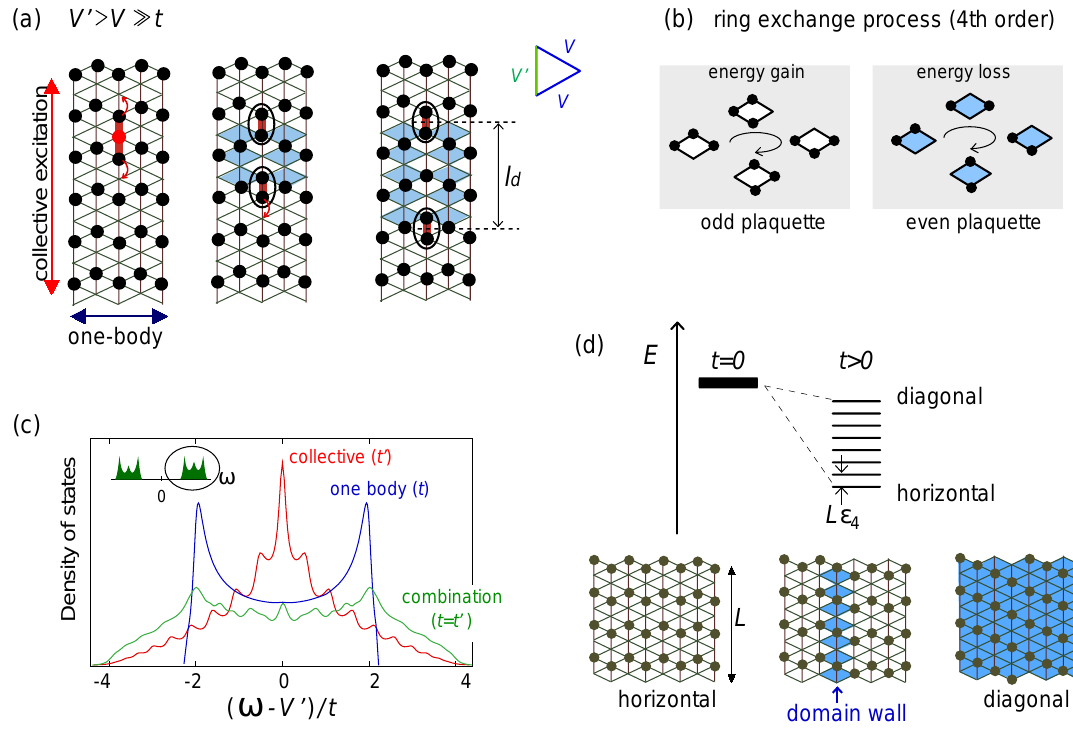
Figure 12. ( a ) Sketch of spinless particles in the strong coupling regime of the anisotropic = N/ 2 + 1 ) triangular lattice t - V model at V (cid:48) > V . Doping one particle to a stripe ( N e generates two •• which separate by distance l due to the successive hopping of many d particles; ( b ) Ring exchange processes on a plaquette with odd/even numbers of particles (cid:80) A ( k, ω ) ) of this collective gain/lose the energy; ( c ) Many body density of states ( k excitation ( t (cid:48) ) together with the one-body excitation ( t ) along the stripe [42]; ( d ) Energy levels of the chain stripe manifolds at V (cid:48) > V (cid:29) t , which have the domain wall excitation. The diagonal/horizontal stripe filled with even/odd plaquettes has the highest/lowest